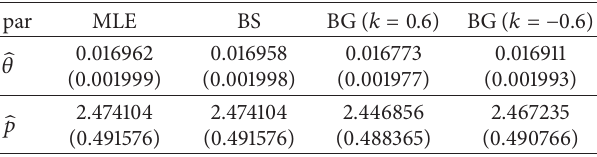
Table 1: Average parameters estimates and their corresponding standard errors (𝑛 = 72) .